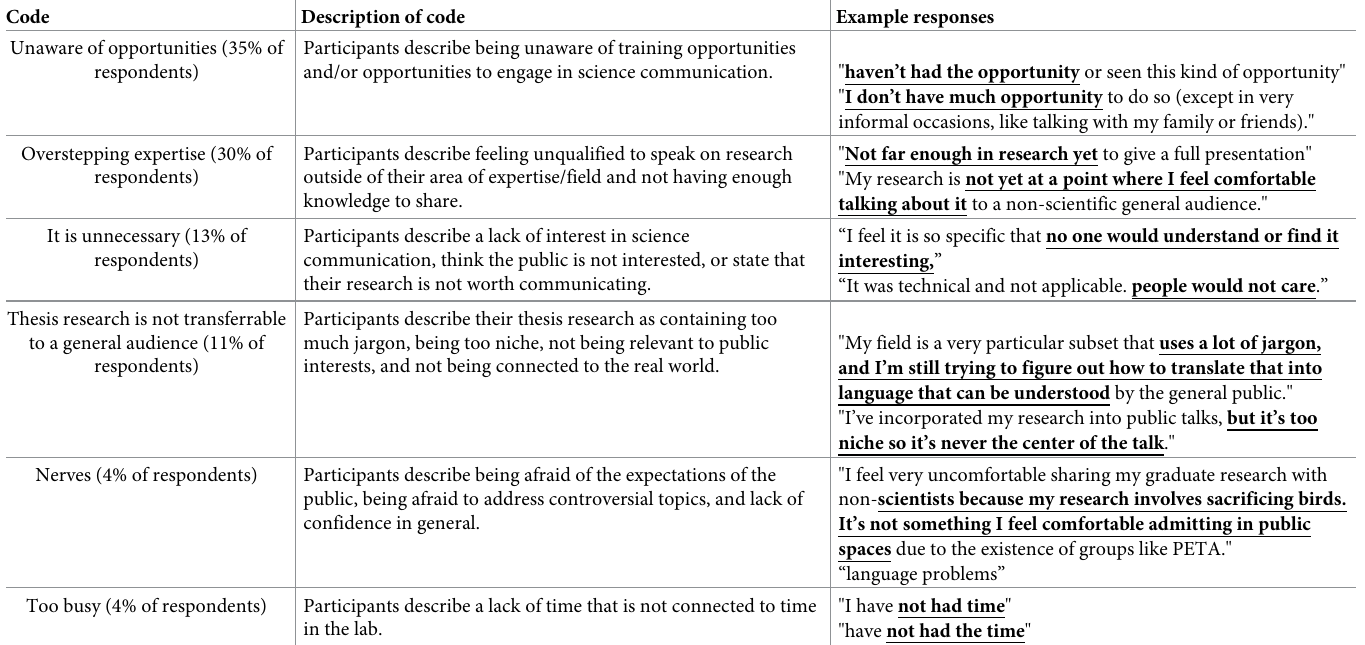
Table 6. Participant responses to the question “what has stopped you from communicating your own thesis research to a non-scientific general audience?” the resulting codes are shown in the left hand column, with a description of each code in the center column, and example responses from participants in the right hand column. Text from each response that is directly relevant to each code is in bold and underlined text.